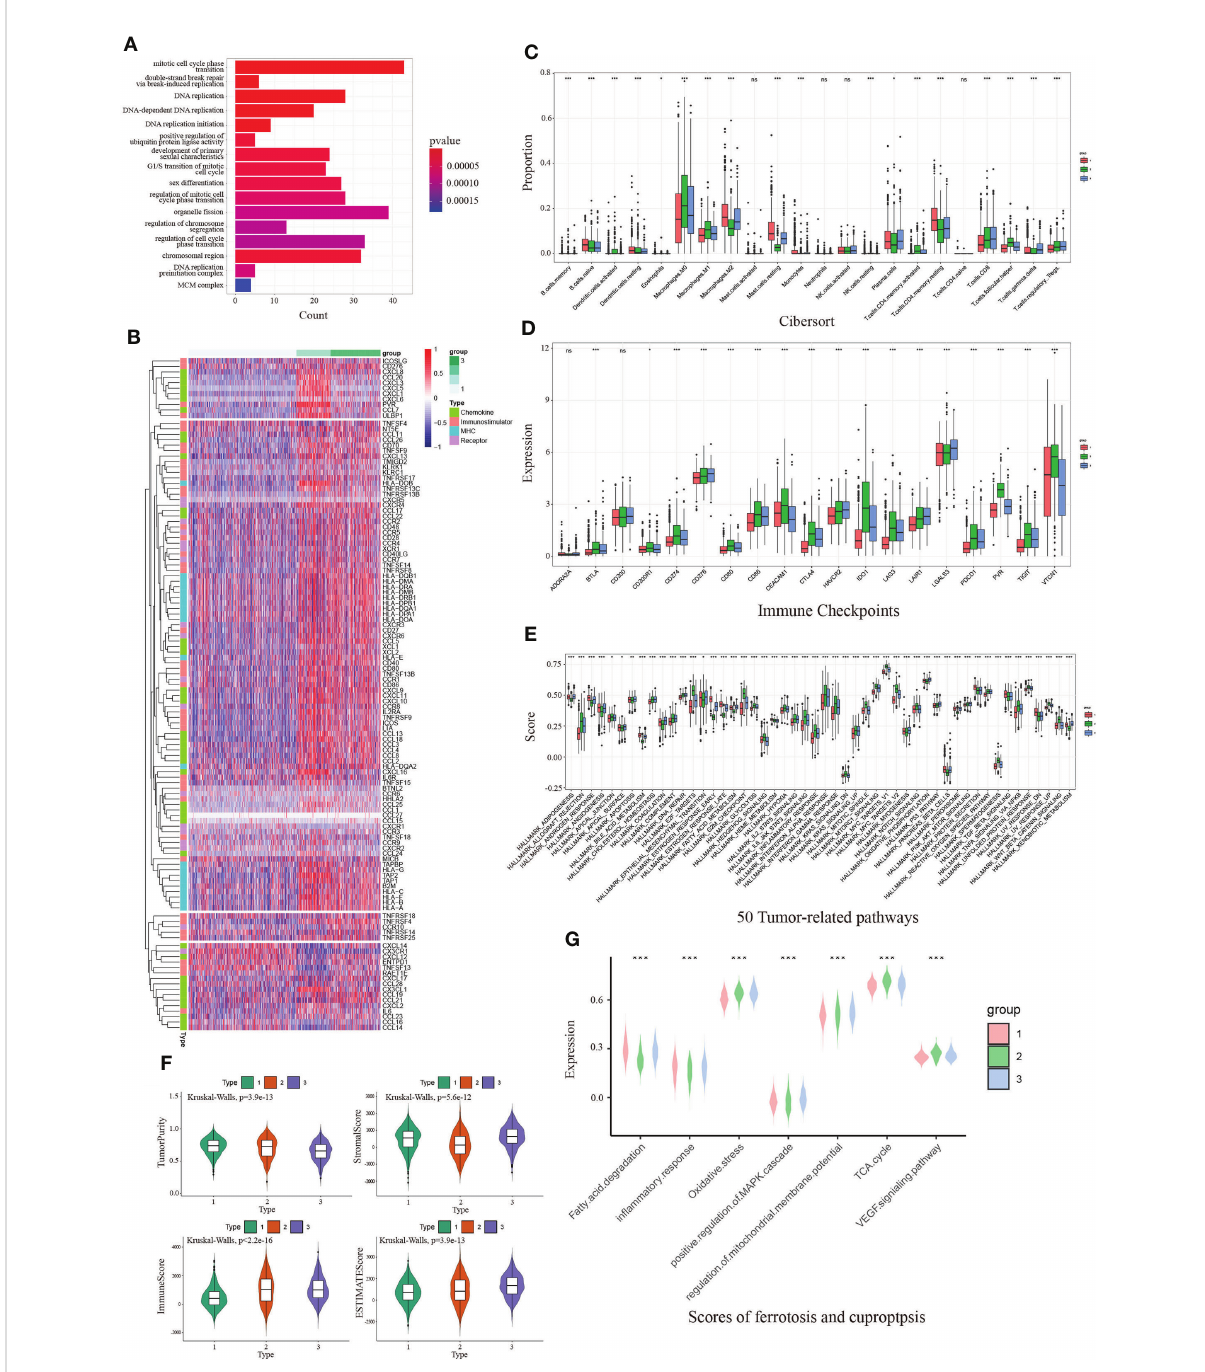
FIGURE 3 The immunological and functional analysis of CDKN2A among 3 groups from unsupervised clustering in BRCA. (A) The GO enrichment analysis revealed the function of CDKN2A-mediated genes. (B) The heatmap depicted each BRCA patient with a difference of a corresponding enrichment of 122 immunomodulators. (C) Comparison of in fi ltration of immune cells between 3 groups. (D) Comparison of immune checkpoints expression between 3 groups in BRCA. (E) Comparison of 50 tumor-related pathways between 3 groups in BRCA. (F) Comparison of estimate score, immune score, stromal score, and tumor purity between 3 groups in BRCA. (G) Comparison of scores offerroptosis and cuproptosis between 3 groups in BRCA. The P values of the fi gure are shown as follows: *P < 0.05. **P < 0.01. ***P < 0.001. ns (not signi fi ciant, P >